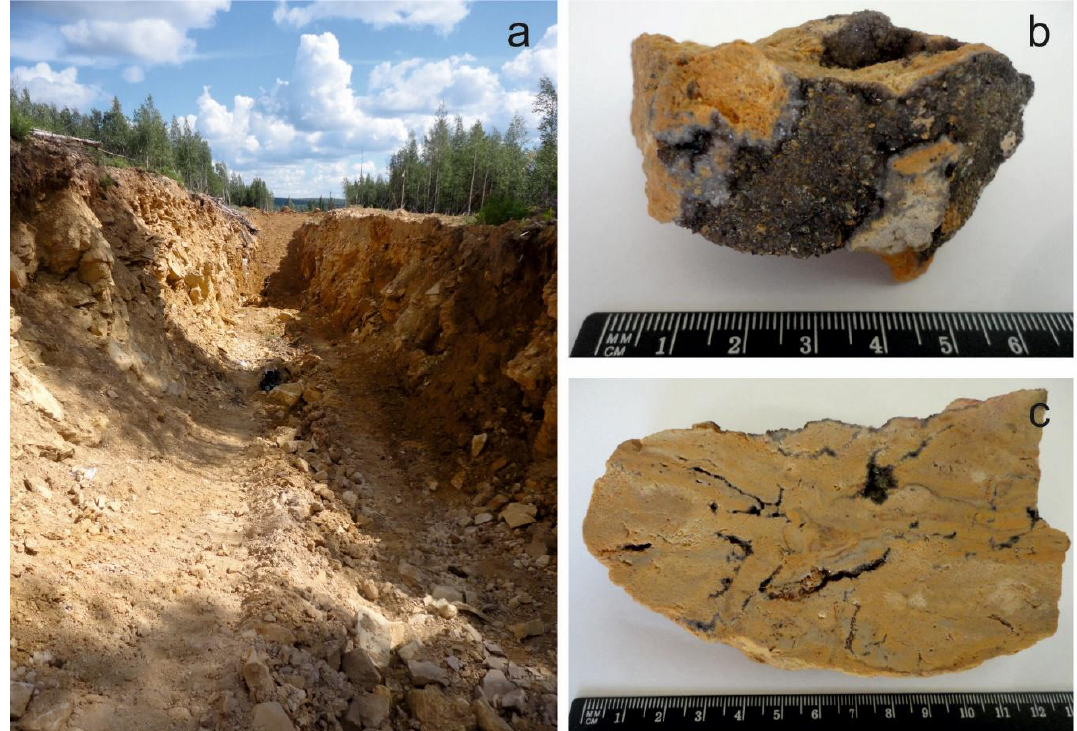
Figure 2. Ore bearing karst, ( a ) general look, ( b ) pyrite-adular-quartz jasperoids, ( c ) section of b .